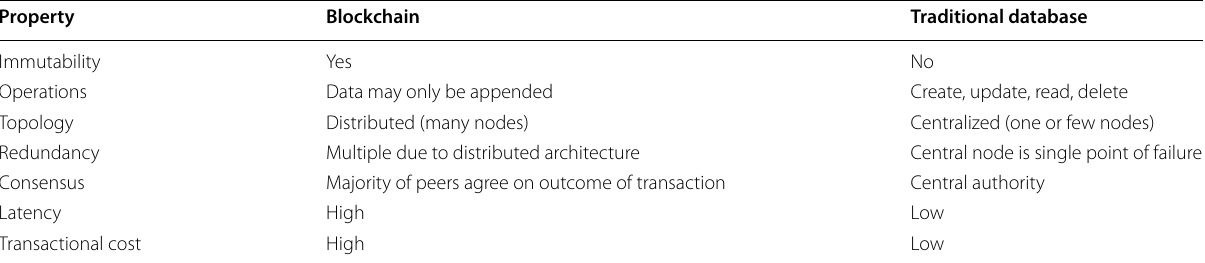
Table 1 Comparison of traditional database vs. blockchain (modified from McBee et al. [4]) Property